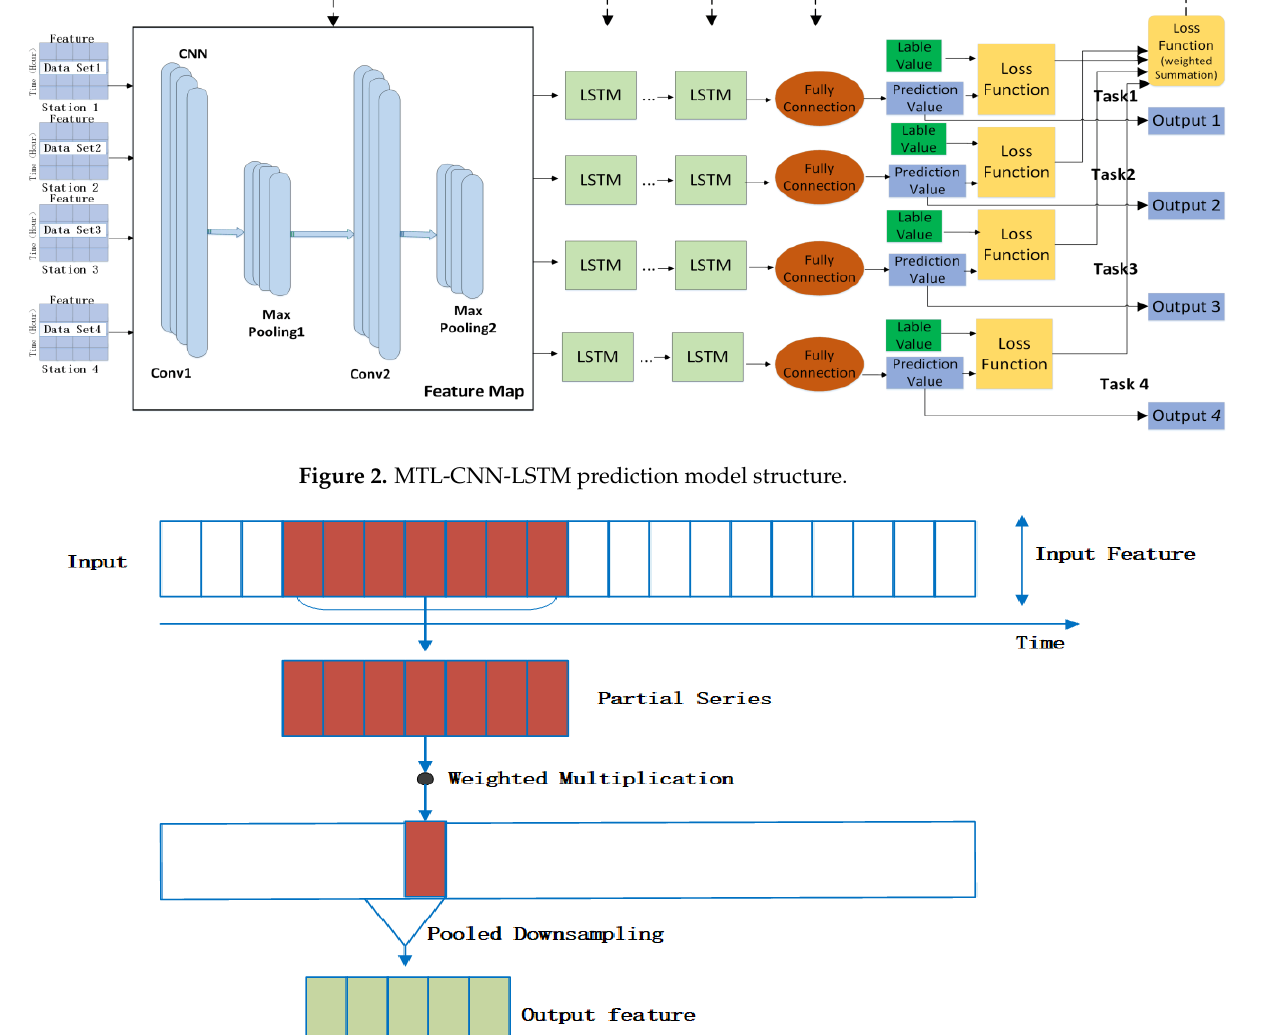
Figure 2. MTL-CNN-LSTM prediction model structure.